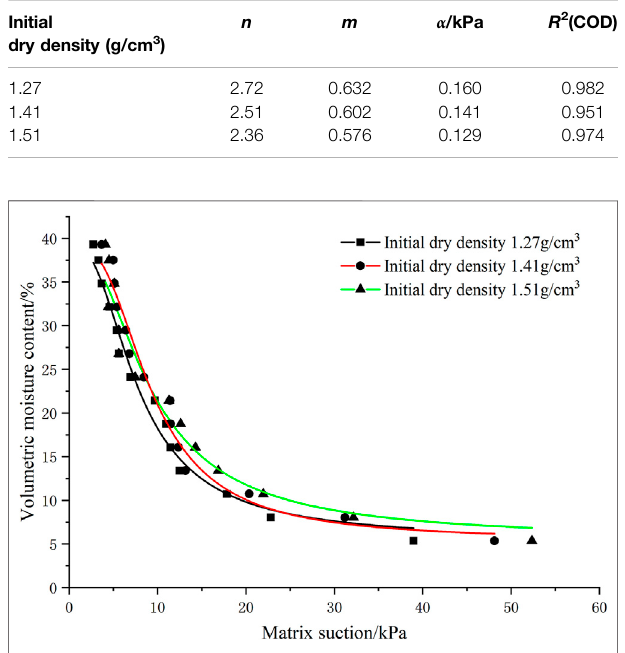
FIGURE 9 | The experimental data and best- fi t SWCC of tailings at different initial dry densities.